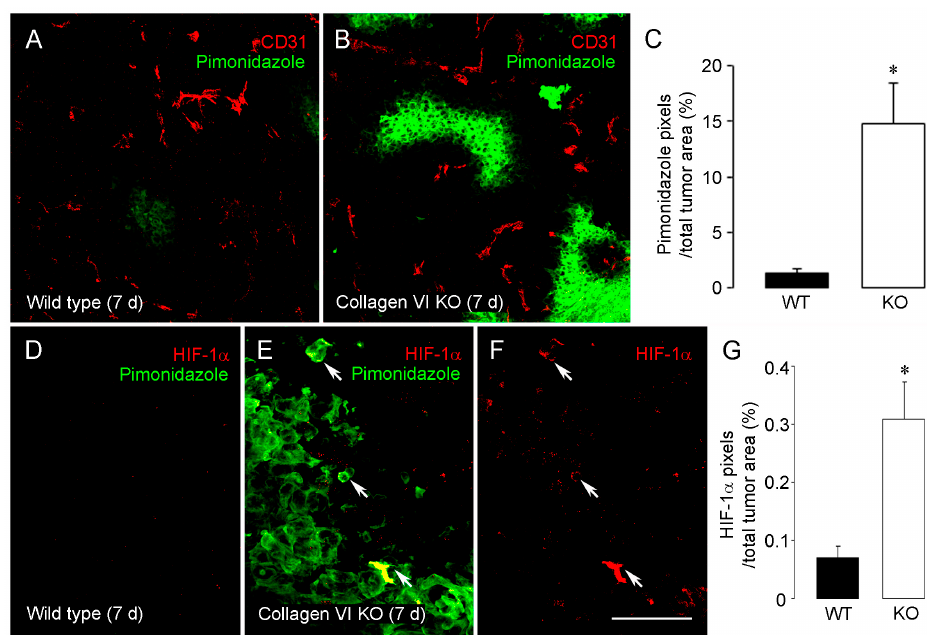
Figure 1. Increased hypoxia and HIF1 α expression in tumors in collagen VI null mice. Hypoxia levels in 7-day intracranial B16F10 tumors were determined after intravenous injection of a pimonidazole hypoxia probe (60 mg/kg, 1 h circulation period). Tumor sections were double-stained for pimonidazole (green) and CD31 (red). In contrast to rare pimonidazole-positive regions in wild type tumors ( A ), areas of intratumoral hypoxia were markedly increased in tumors from collagen VI null mice ( B ). Intratumoral hypoxia levels, defined as the percentage of total tumor area covered by pimonidazole pixels, were increased 10-fold in collagen VI null mice ( C ). Very low levels of immunolabeling for HIF-1 α (red) were detected in tumors in wild type mice ( D ), in agreement with the virtual absence of immunolabeling for pimonidazole (green). In tumors in collagen VI null mice, increased hypoxia detected via pimonidazole labeling was accompanied by more abundant labeling for HIF-1 α (( E ) and ( F )). HIF-1 α levels are more than 3-fold higher in collagen VI null mice than in wild types ( G ) * p < 0.05 vs. wild type. Scale bar: 120 µ m in ( A ) and ( B ); 40 µ m in ( D – F ). Data taken from (You et al.